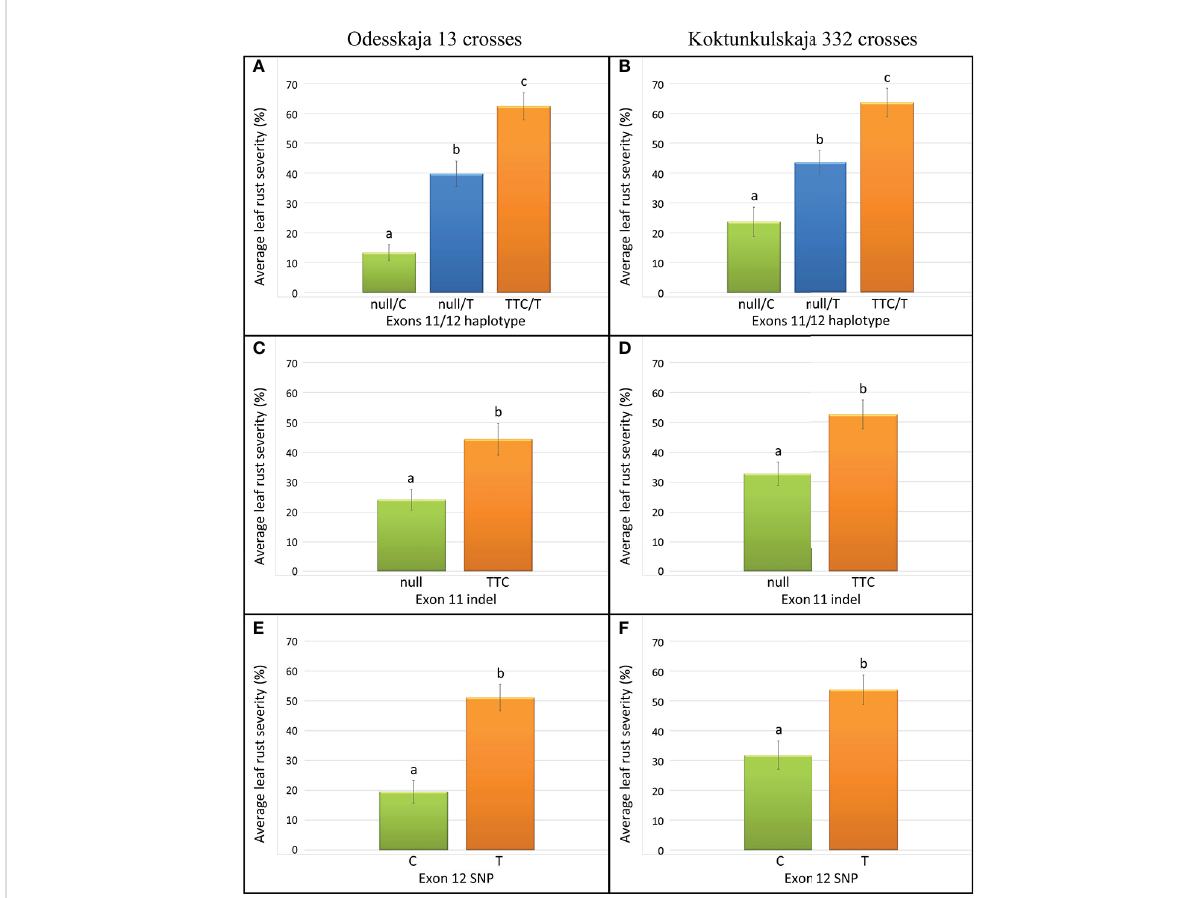
FIGURE 3 Leaf rust severity (%) of lines from the Odesskaja 13 crosses (A, C, E) and the Koktunkulskaja 332 crosses (B, D, F) obtained by averaging over all environments and years and classi fi ed according to their genotype at exons 11/12 (A, B) , exon 11 only (C, D) and exon 12 only (E, F) . Letters above the error bars indicate statistical signi fi cance ( P <